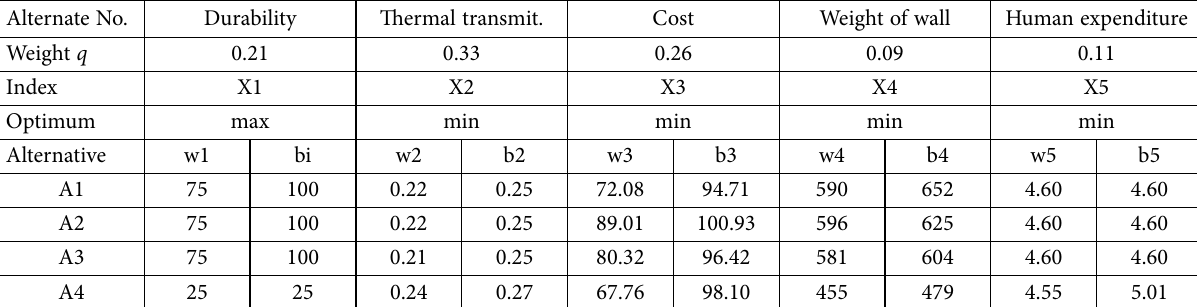
Table 1. Initial decision-making matrix with values expressed in intervals Alternate No.